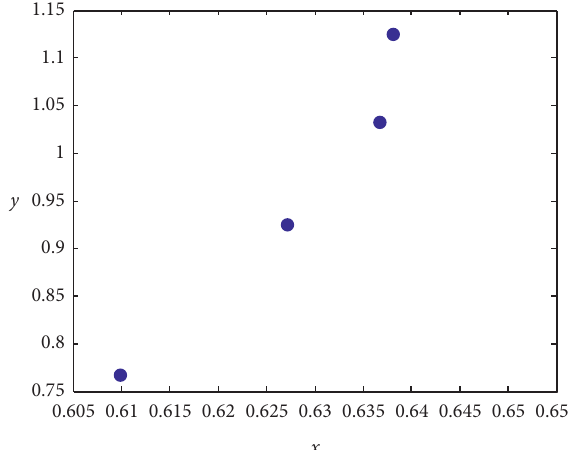
Figure 22: x - n sequence diagram which denotes that the system is 8-fold periodic when c � 0.15.